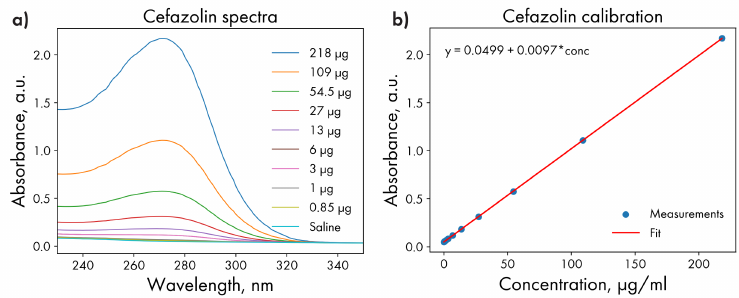
Figure A1. Absorbtion spectra ( a ) and calibration plots ( b ) for Cefazolin. Table A1. Optimized parameters and features needed to film